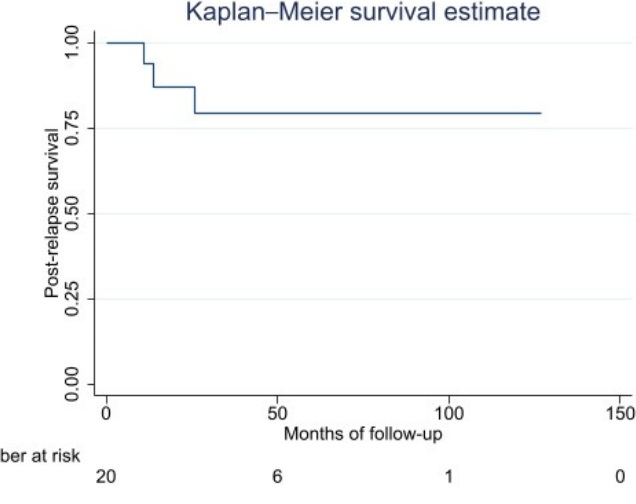
Figure 3. Post-relapse survival estimates. Metastasis treatment consisted of surgery alone (25%) or surgery combined with RT and Cht (55%). The preferred surgical procedure was excision (90%), though two patients were treated with amputation (one of them in combination with RT and the other with Cht). Four patients (20%) were treated with surgery and RT, and four patients (20%) had surgery plus Cht. The other three patients were treated with RT, surgery, and Cht. Among the 20 metastatic patients, only two were not treated with surgery (10%): one underwent Cht, and another was treated with RT. The last two patients did not undergo treatment (one patient underwent early palliative care, the other refused adjuvant therapies). No risk factors for PRS could be identified.